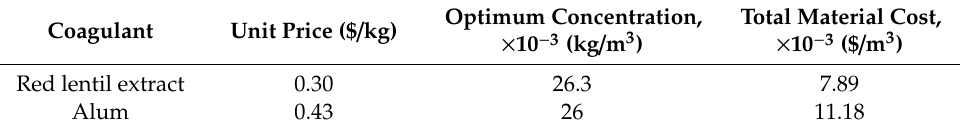
Table 6. Cost of red lentil extract and alum in turbidity